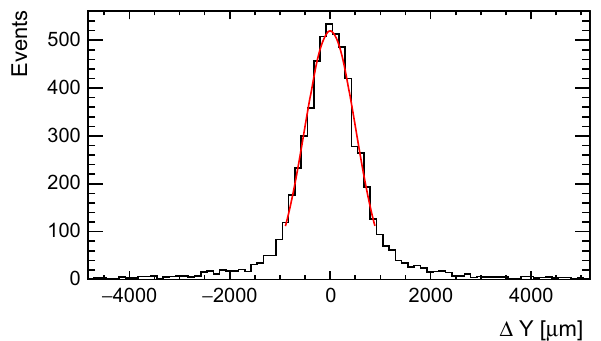
Fig. 22 The distribution of the residuals between the reconstructed and the predicted position of the showering particle, Δ Y . The curve represents the Gaussian fit to the distribution